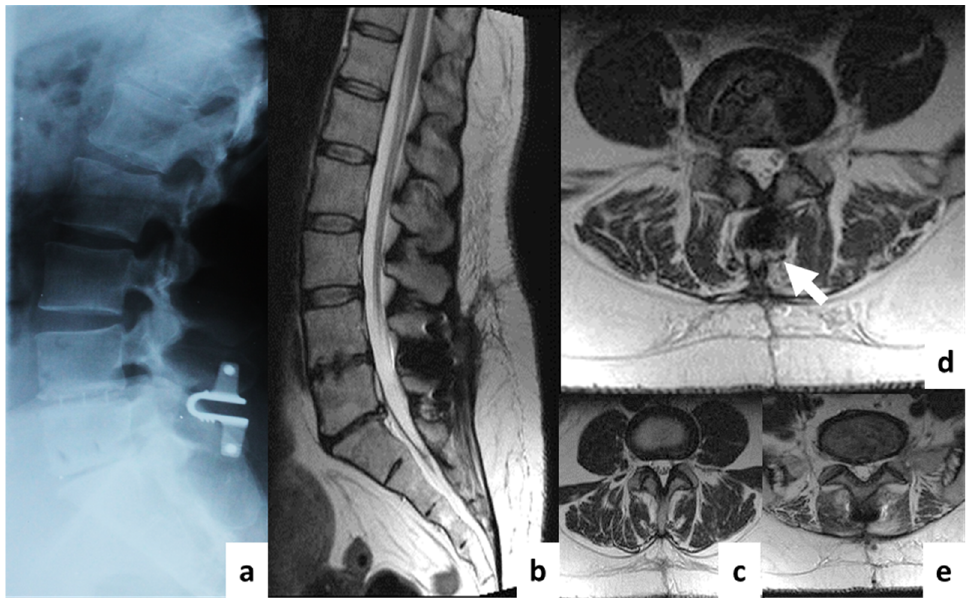
Figure 3. Postoperative T2w MRI of a 44-year-old male from group IIa with degenerative disc disease at L4–L5. ( a )—sagittal X-ray; ( b )—sagittal MRI; ( c )—axial MRI at L3–L4 (overlying segment); ( d )—axial MRI at L4–L5 (operation level); ( e )—axial MRI at L5–S1 (underlying segment). The white arrows indicate regions with visible artifacts.